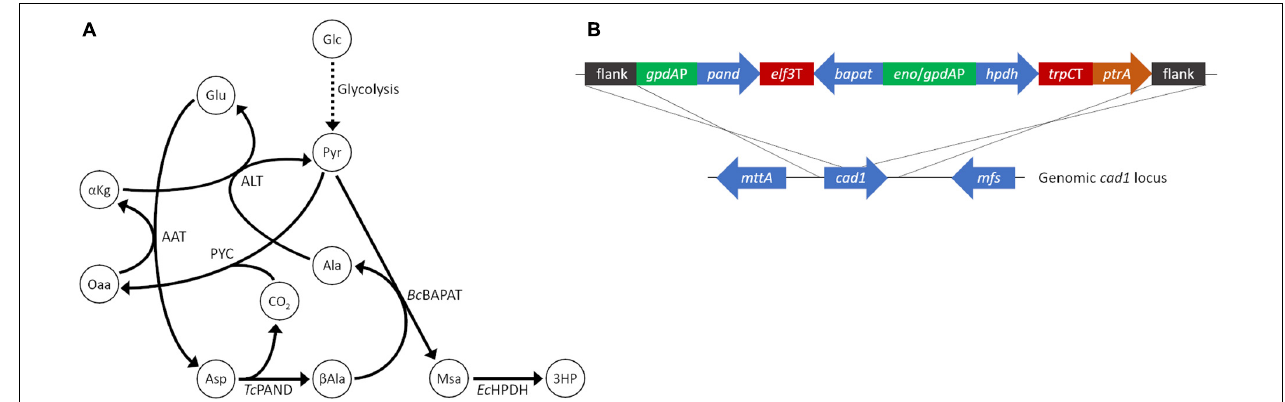
FIGURE 1 | Establishment of 3HP production in A. pseudoterreus . (A) Ideal carbon flux in a high theoretical yield (2 mol/mol) metabolic pathway for production of 3HP from sugar monomers. (B) The beta-alanine metabolic pathway to enable 3HP production was codon optimized for A. pseudoterreus and placed under the control of high expression promoters. The engineered pathway was targeted to the cis -aconitic acid decarboxylase ( cad 1) locus to disrupt the gene. 3HP, 3-hydroxypropionate; AAT, aspartate aminotransferase, Ala, alanine; ALT, alanine transaminase; α Kg, alpha-ketoglutarate; Asp, Aspartate; β Ala, beta-alanine; Bc BAPAT, beta-alanine pyruvate aminotransferase; Ec HPDH, 3-hydroxypropionate dehydrogenase; Glc, glucose; Glu, glutamate; Msa, malonate semialdehyde; Oaa, oxaloacetate; PYC, pyruvate carboxylase; Pyr, pyruvate; Tc PAND, aspartate